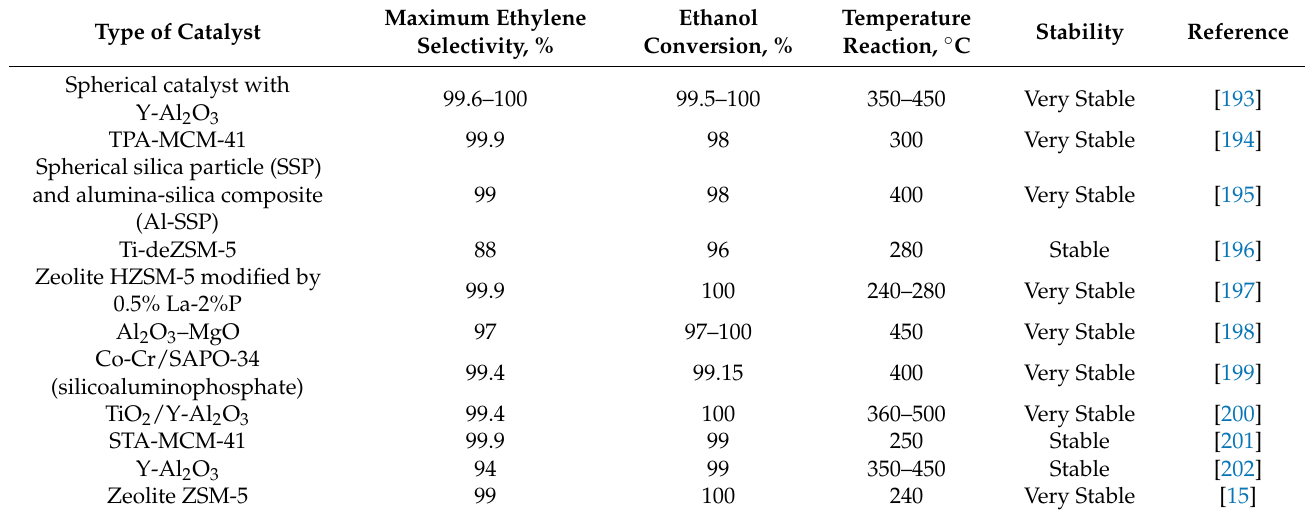
Table 8. Dehydration of ethanol to ethylene by using different